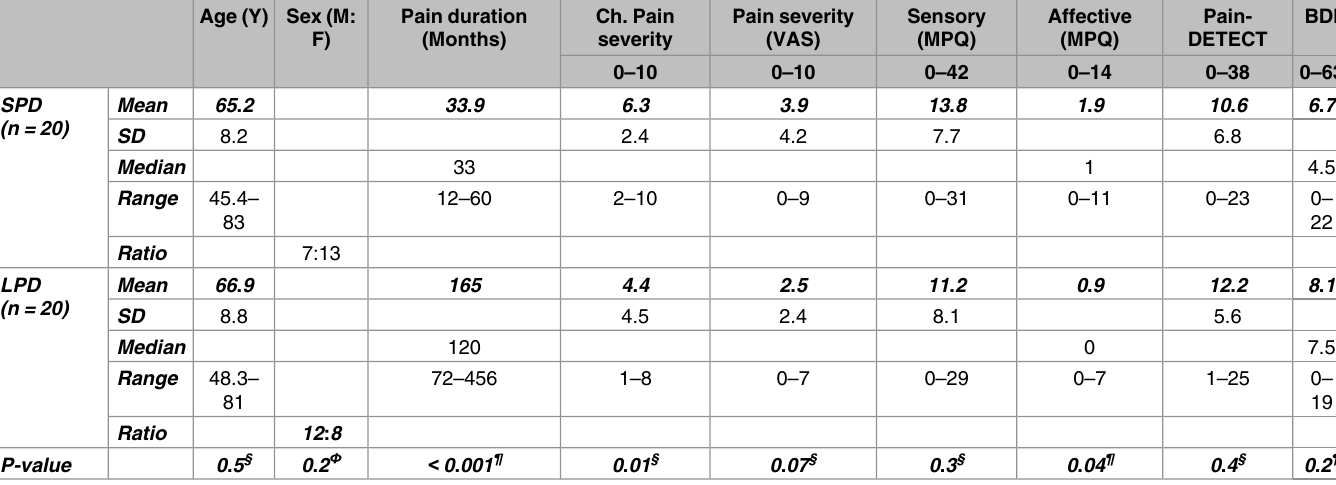
Table 2. Demographic data and pain characteristics of short vs. long pain duration